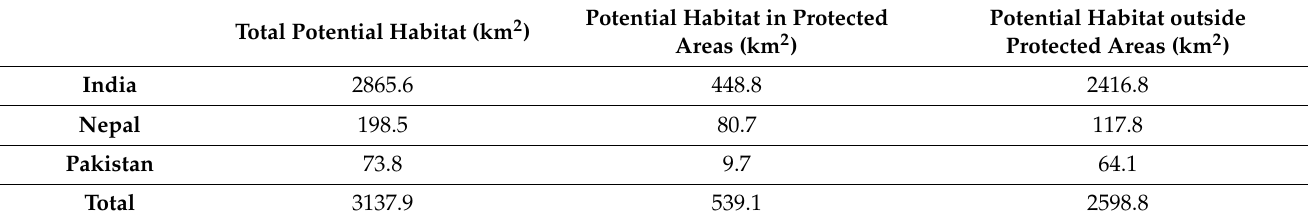
Figure 4. Distribution and habitat suitability map of cheer pheasant from the best-fitting model. Table 3. The estimated extent of cheer pheasant habitat within and outside protected